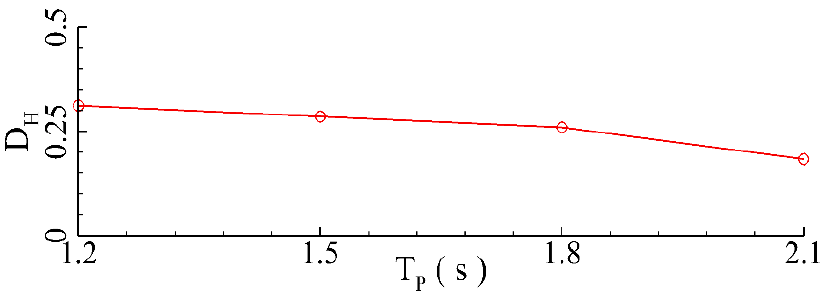
Figure 21. Spatial distribution of local maximum wave height under peak wave periods.